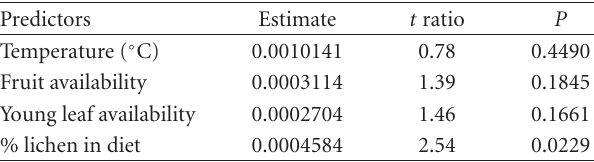
Figure 2: Lichen load per 400 m 2 plot correlated with altitude (in m above seal level). Table 1: GLM with monthly use of altitude as the response and temperature, fruit availability, young leaf availability and the reliance on lichen as predictors (whole model test: F = 3.5173, R 2 = 0 . 484, P =